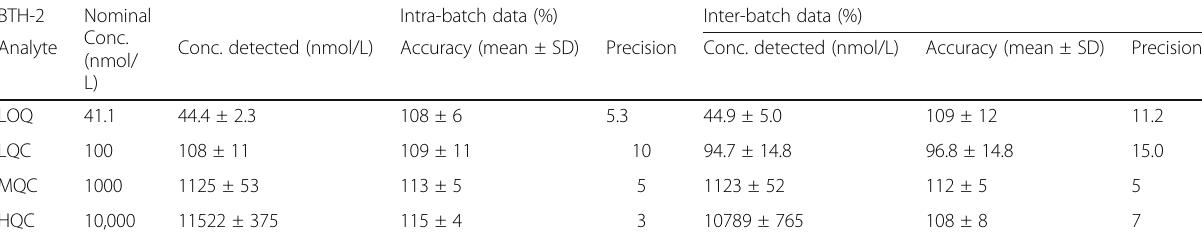
Table 3 Intra-batch (n = 6) and inter-batch (n = 6) accuracy and precision for the analysis of bromophenol-thiosemicarbazone hybrid in rat